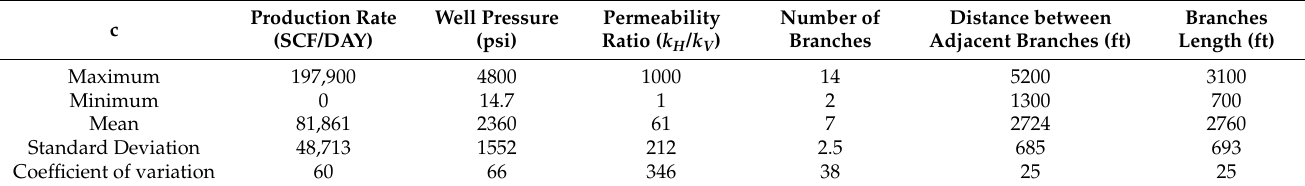
Table 1. Statistical parameters for the studied reservoir